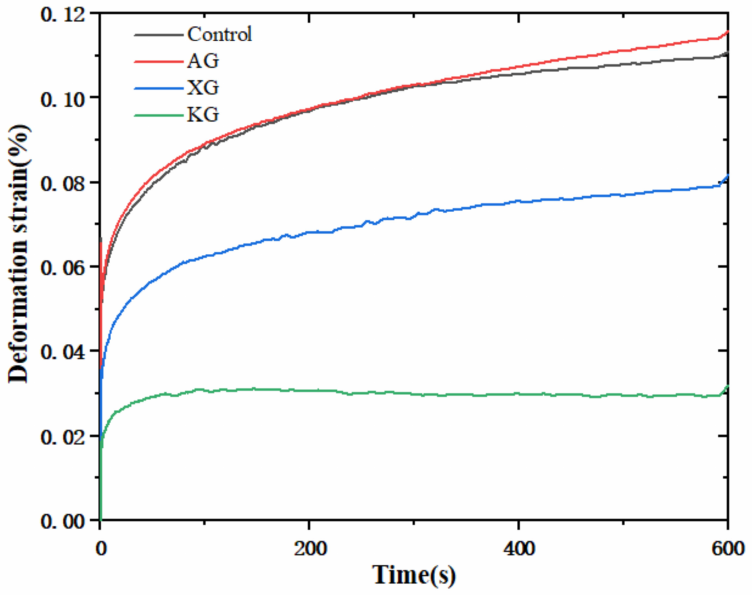
Figure 4. Creep response of ink samples with different formulation at a gum concentration of